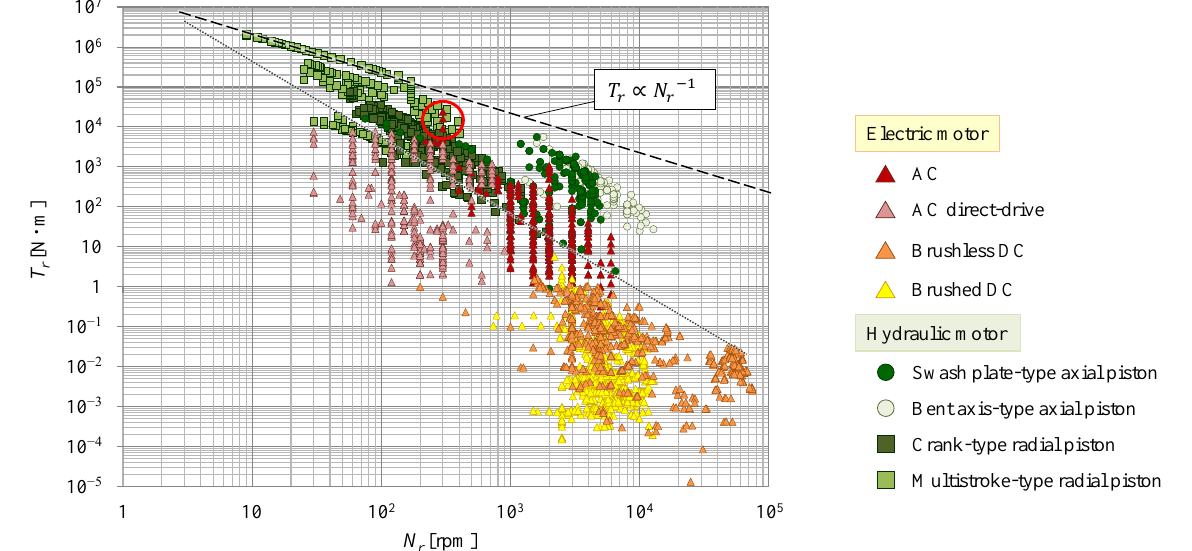
Figure 9. Correlation between rated rotating speed and rated torque.